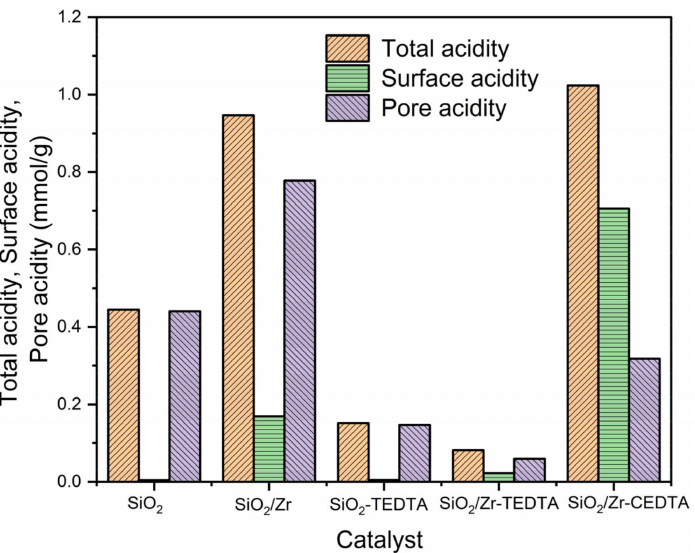
Figure 7. Total, surface, and pore acidity of the